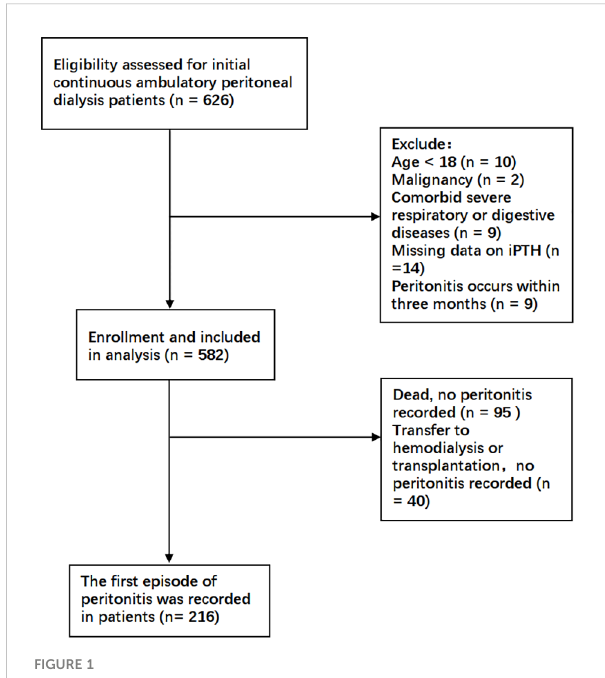
FIGURE 1 Flowchart for patient